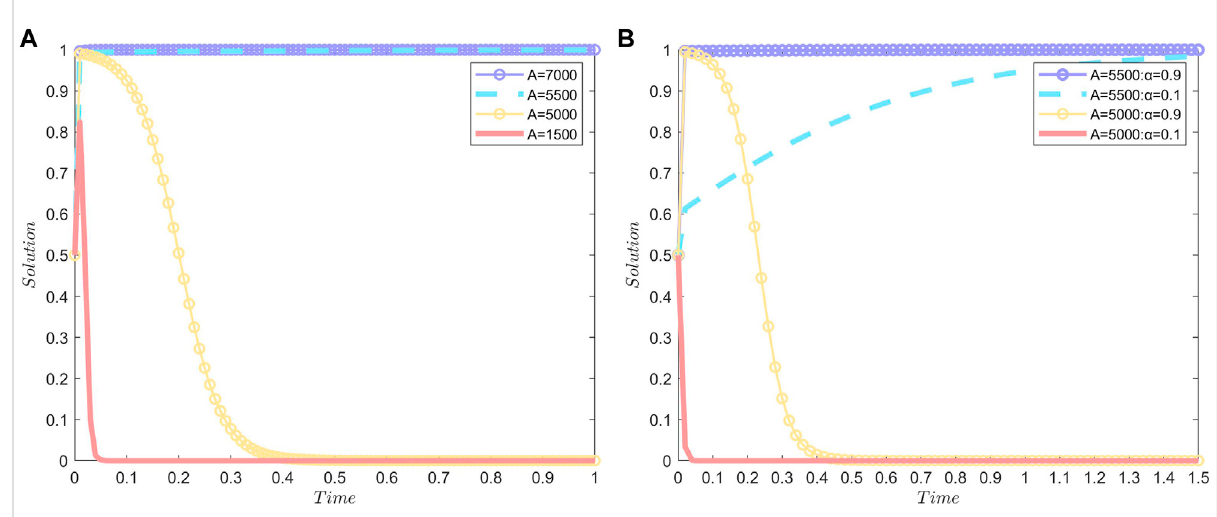
FIGURE 5 Comparison of the (A) impact of the total amount of waste (B) impact of the conversion ef fifi ciency of waste.